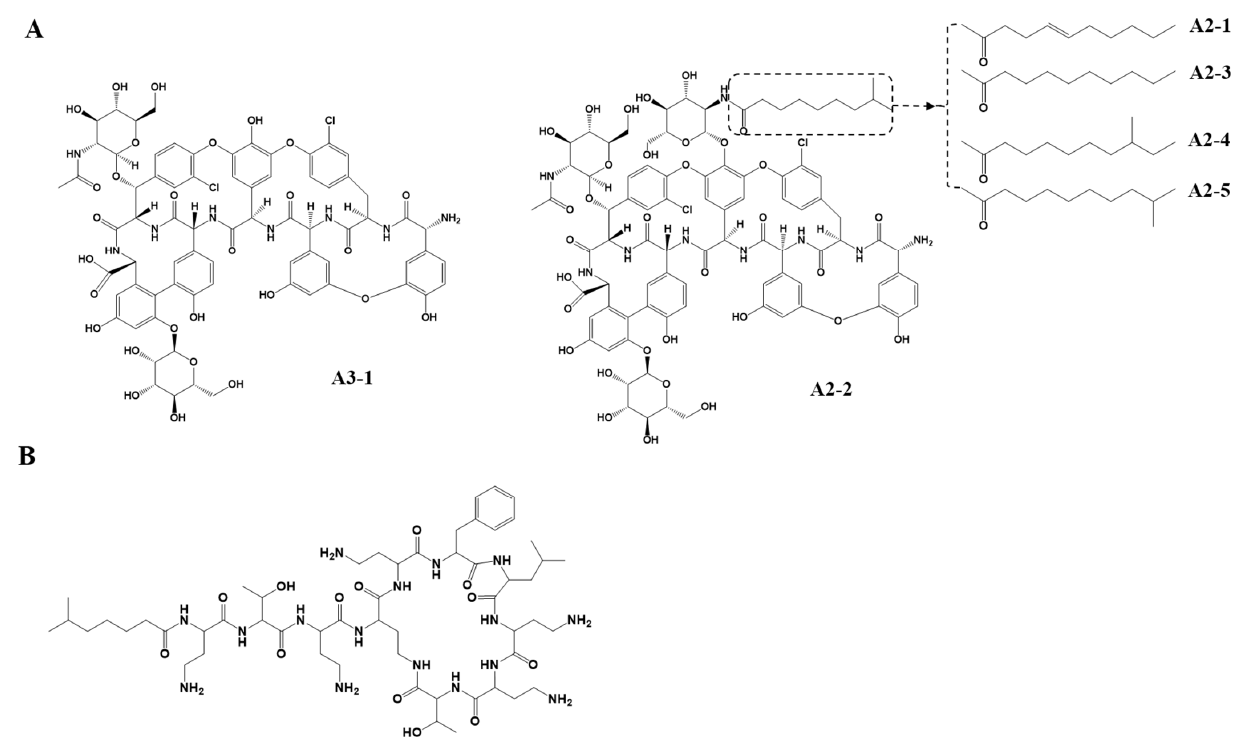
Figure 1. The structures of teicoplanin ( A ) and polymyxin B2 ( B ). First, the UV detector wavelength was set at 220 nm to optimize the sensitivity for detection of the major peaks of teicoplanin and polymyxin B (B1 and B2), which is consistent with the previously used UV wavelengths between 210 nm and 240 nm for teicoplanin [5,14,17,18] (Supplementary Figure S1A,B). Next, various conditions of the mobile phase, specifically pH and hydrophilicity, were investigated to eliminate any in- terference between the A2-2 teicoplanin (the major isoform) peak and the endogenous peaks of human plasma for optimal separation of each peak (Supplementary Figure